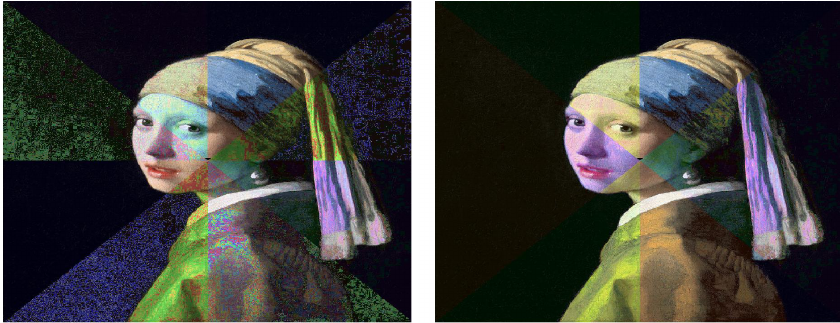
Figure 6. Color symmetry of the full image of Vermeer’s Girl with a Pearl Earring , see Figure 5a,c.